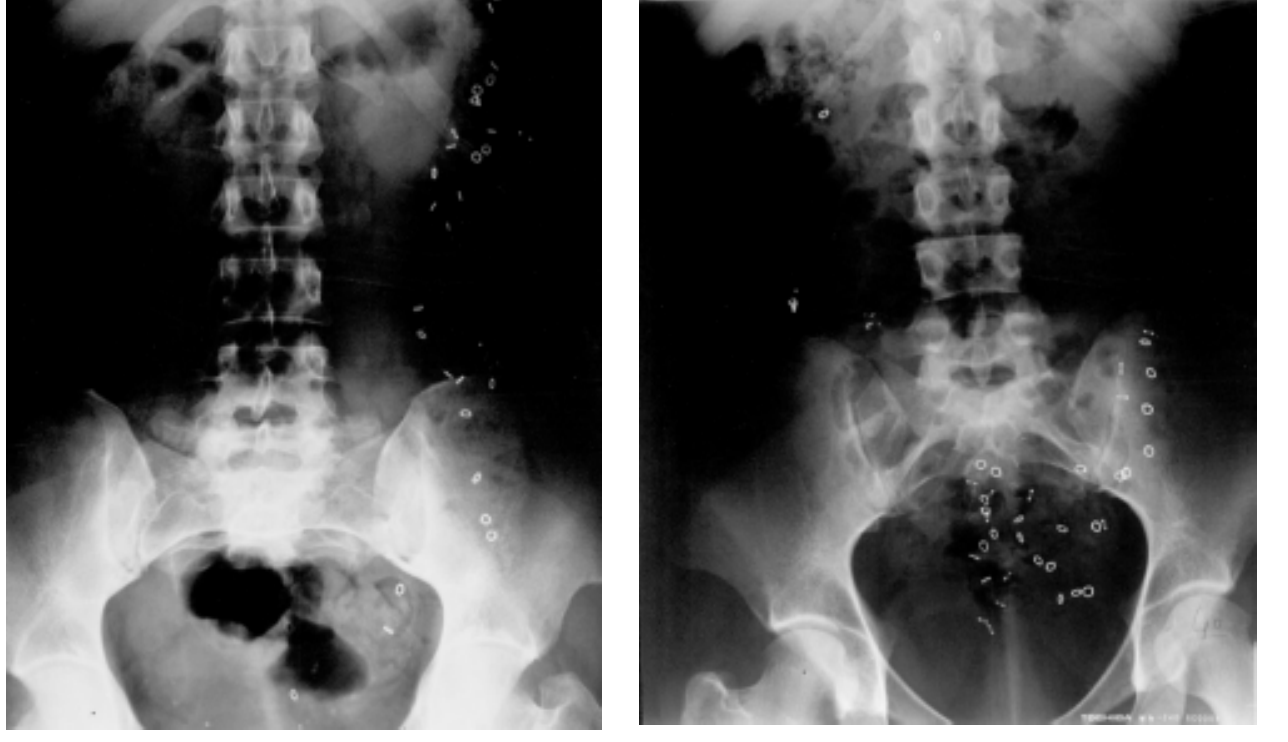
Figure 4 - Outlet obstruction in a patient with idiopathic constipation (IC). An X-ray taken on day 4 shows aggregation of markers in the rectosigmoid. The same pattern was observed on day 7.